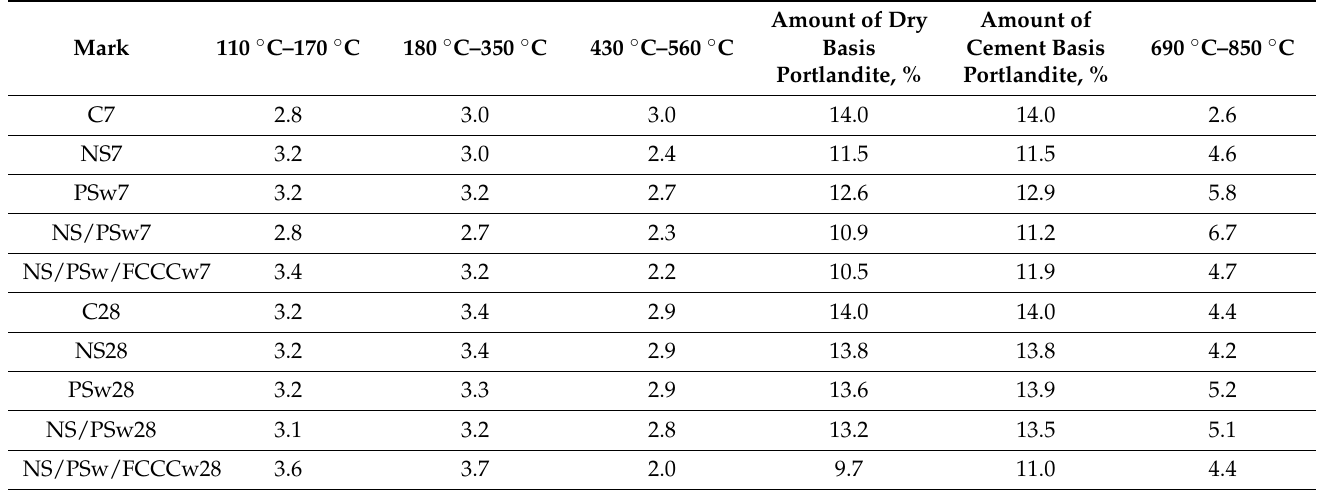
Table 2. Mass loss in decomposition temperature ranges at 7 and 28 days.